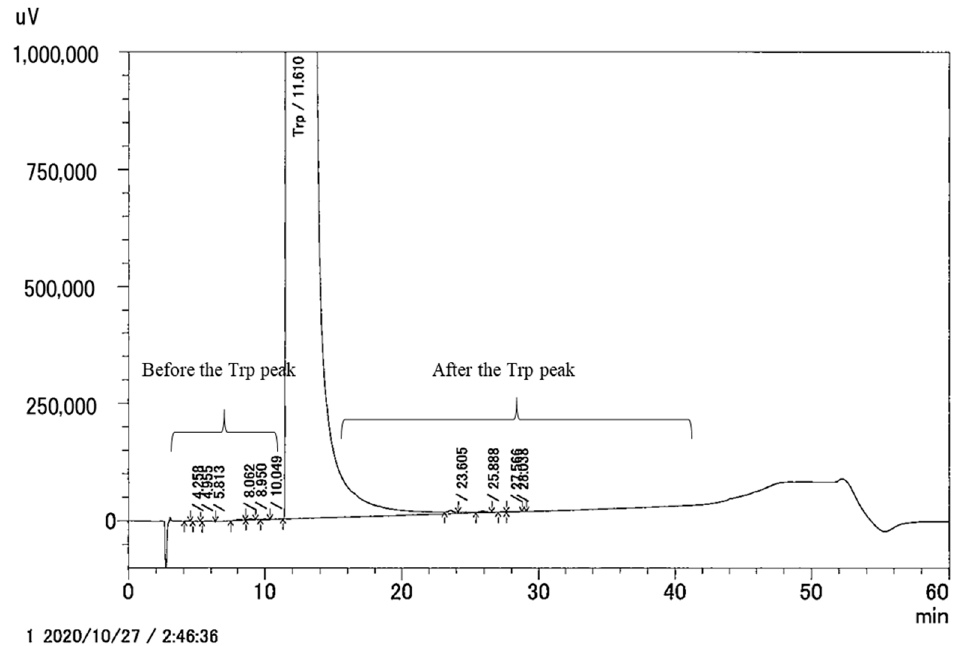
Figure 1. UV (220 nm) chromatograms of Trp dietary supplements. The analysis was performed based on the FCC monograph (12th edition). Reprinted with permission from Ref. [3]. Table 2. Total impurities in the tested tryptophan (Trp) products. Reprinted with permission from Ref. [3].